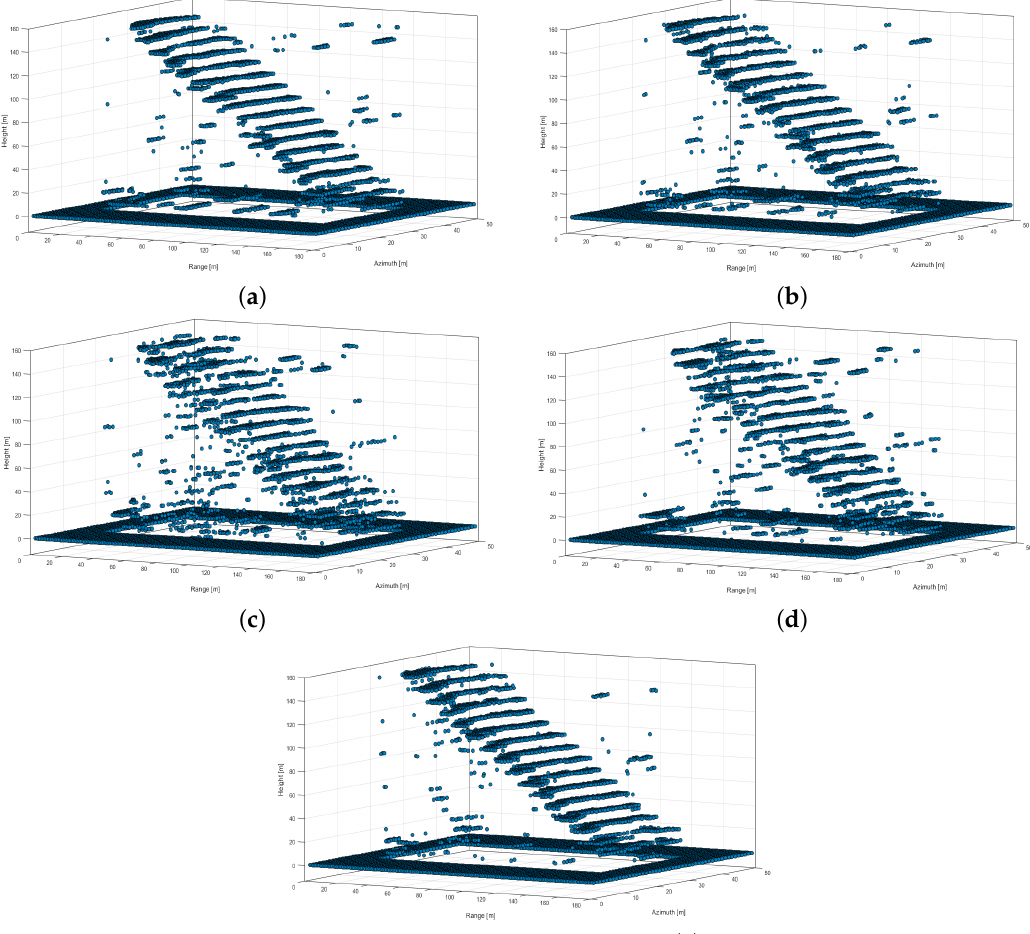
Figure 12. Three-dimensional views of the Mapfre height maps generated by the ( a ) Standard MUSIC estimator, ( b ) BIC-MUSIC estimator and ( c ) Minimum-Norm estimator, ( d ) Regularized Minimum-Norm estimator, and ( e ) the proposed non-parametric MUSIC